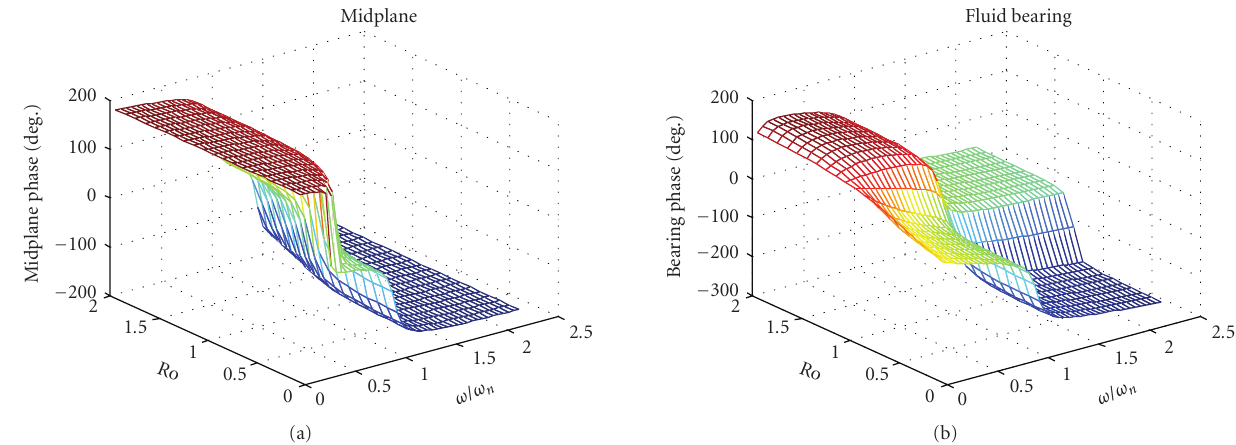
Figure 5: Phase at midspan (a) and at the fluid bearing (b) for an imbalanced rotor with varying amount of bow. The bow plane is opposite the imbalance.